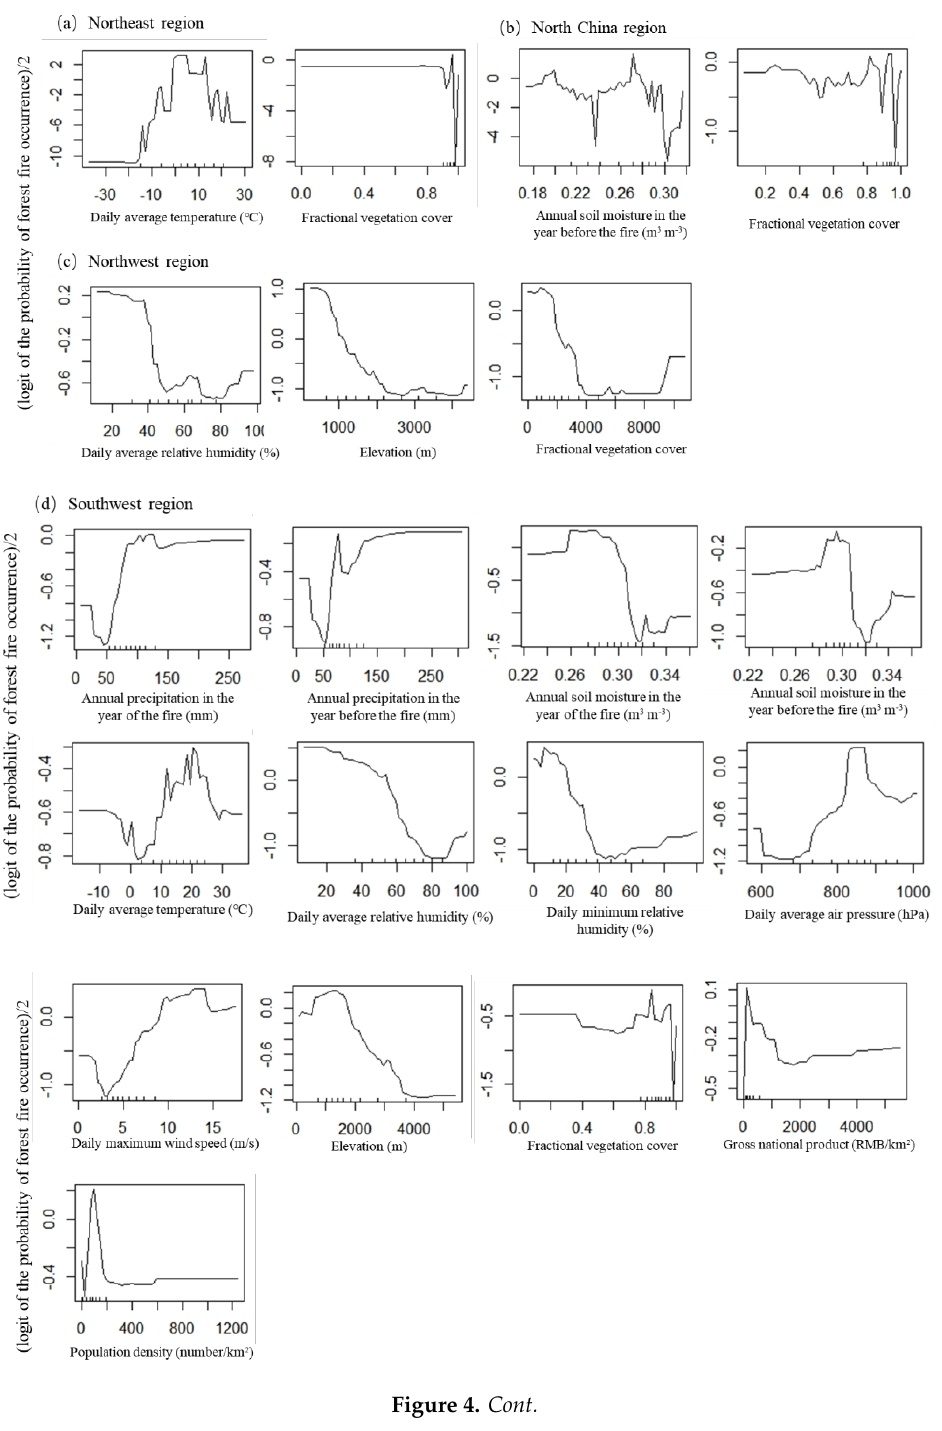
Figure 4. Partial dependence plots of each forest fire driving in six geographical regions and the whole study area. 3.3. Model Prediction Accuracy in Different Regions The AUC values of each final model and intermediate model are greater than 0.85, and the prediction accuracy is between 70.0% and 91.4% (Table 5), which indicates that the model predictive capability is good. In the final models, the AUC (0.974) and prediction accuracy (91.4% for training and 89.3% for testing) in the East China region were the highest. The AUC